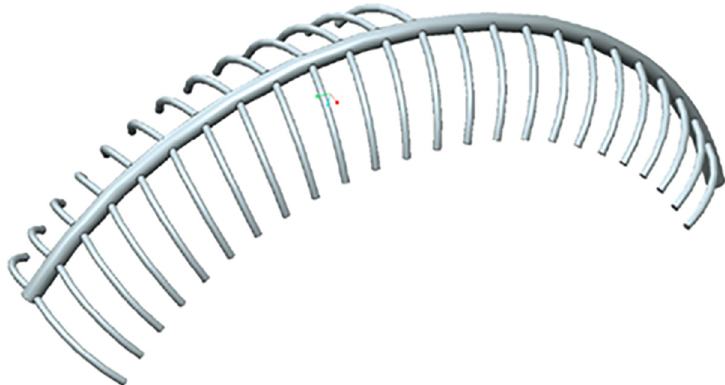
Fig 7. Geometrical model of X . derbentina ’s vein system in the area of its lung. To the left: distal part, to the right: part proximal to the heart.